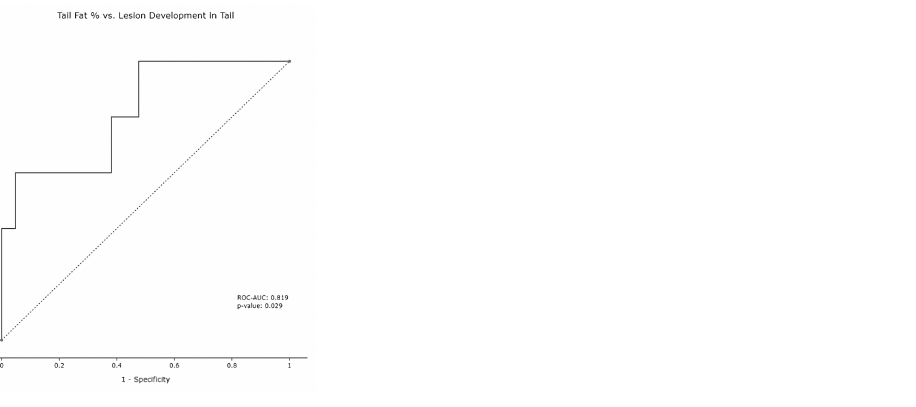
Figure 3. Pancreas Tail ROC Curve. Tail pancreatic fat measurements in subjects ( n = 26) using only the pancreatic tail fat percentage as a feature; a classifier with an ROC-AUC of 0.819 was noted ( p = 0.029).